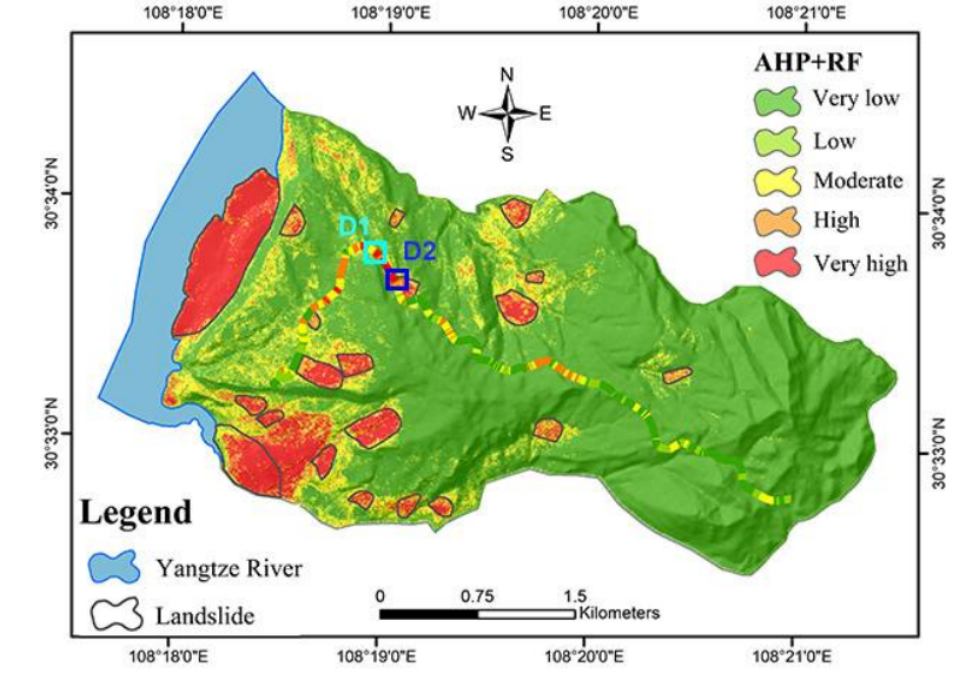
Figure 12. The final landslide susceptibility